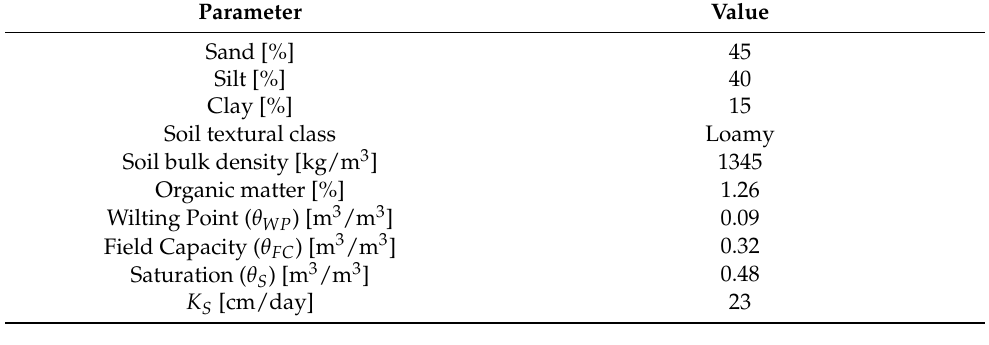
Table 1. Physical and hydraulic parameters of the soil of the experimental site for the depth interval of 0-30 cm. Sand, silt, and clay percentage, as well as bulk density and organic matter, were determined from direct measurements. The soil classification is based on the United States Department of Agriculture method. The soil hydraulic properties, i.e., wilting point ( θ WP ), field capacity ( θ FC ), and saturated hydraulic conductivity ( K S ), are derived from [7].